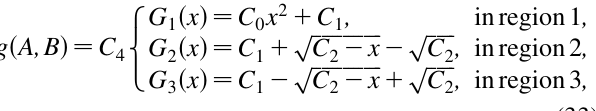
FIG. 8. Plots of the curvature functions scaled by selected powers of r